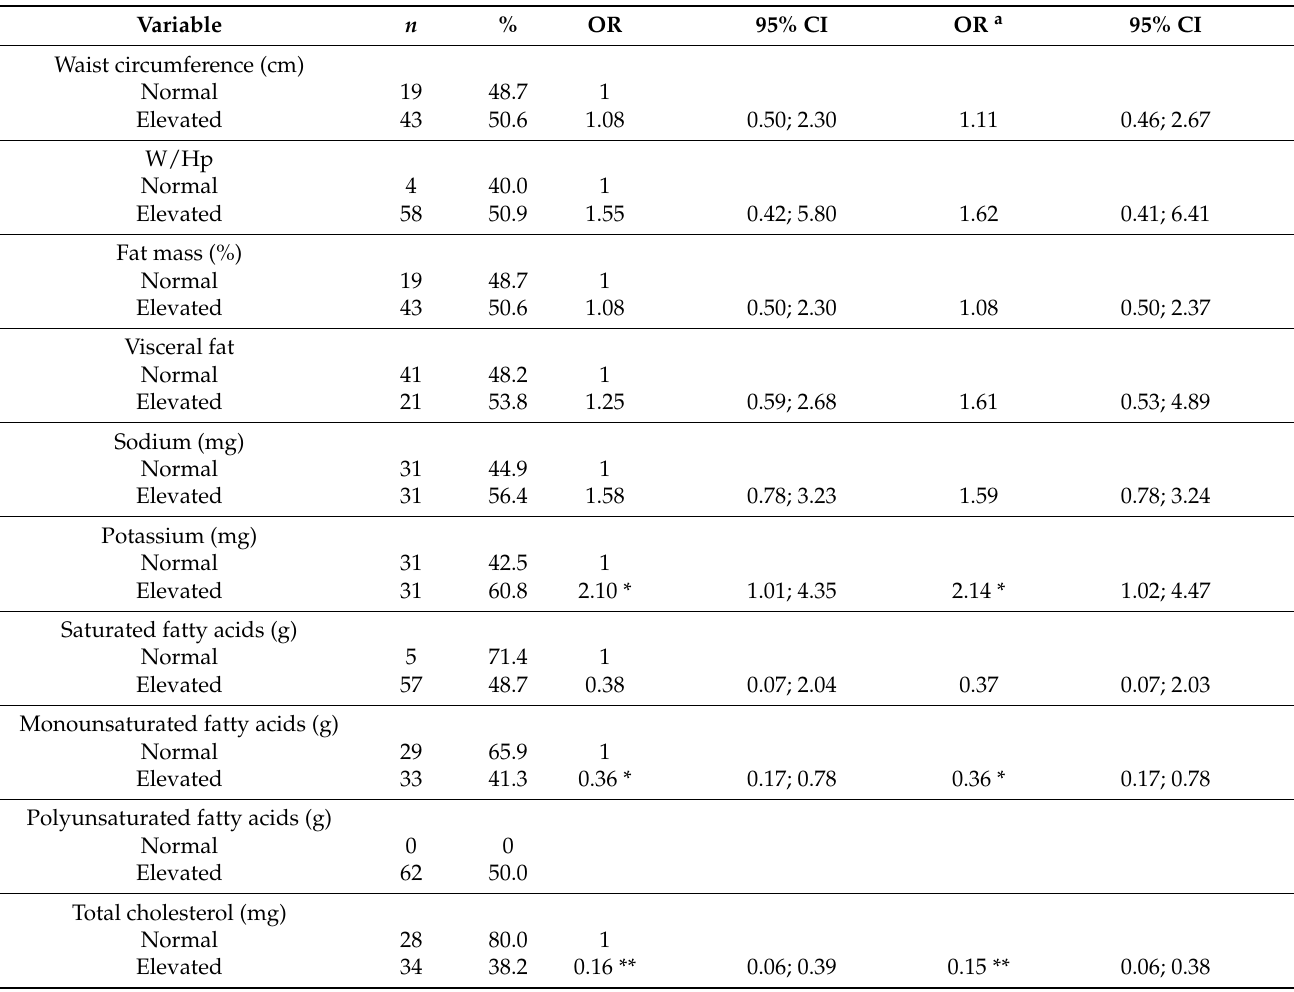
Table 4. The association between the observance of Ramadan and variables related to cardiovascular